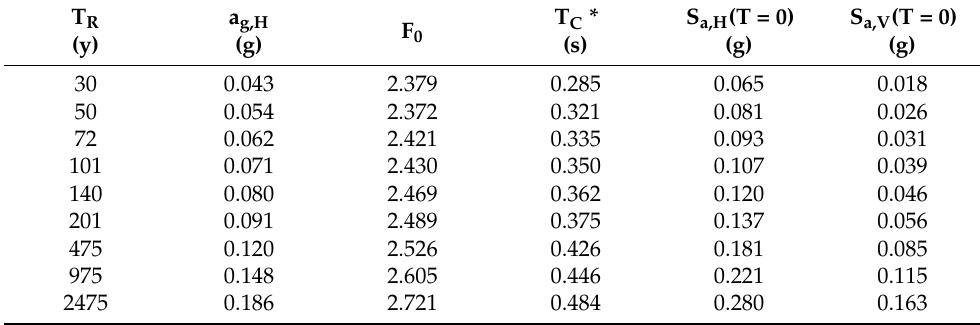
Table 3. Summary of the seismic hazard parameters at the site, Italian NTC 2018.